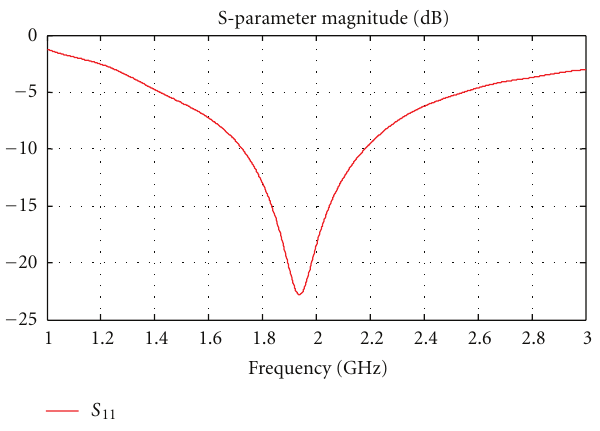
Figure 4: Patch antenna reflection coe ffi cient.